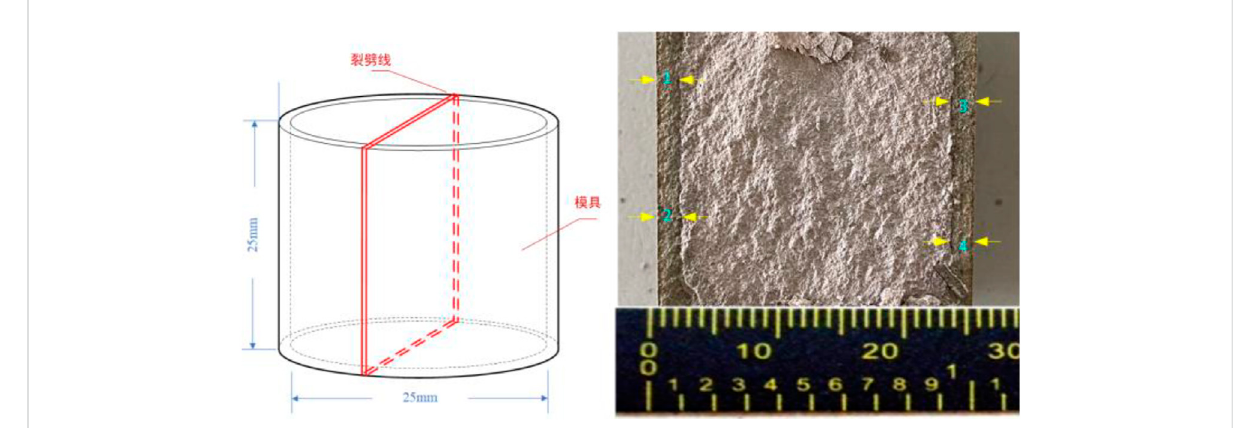
FIGURE 4 Determination method of corrosion depth of cement paste (Zhang et al.,